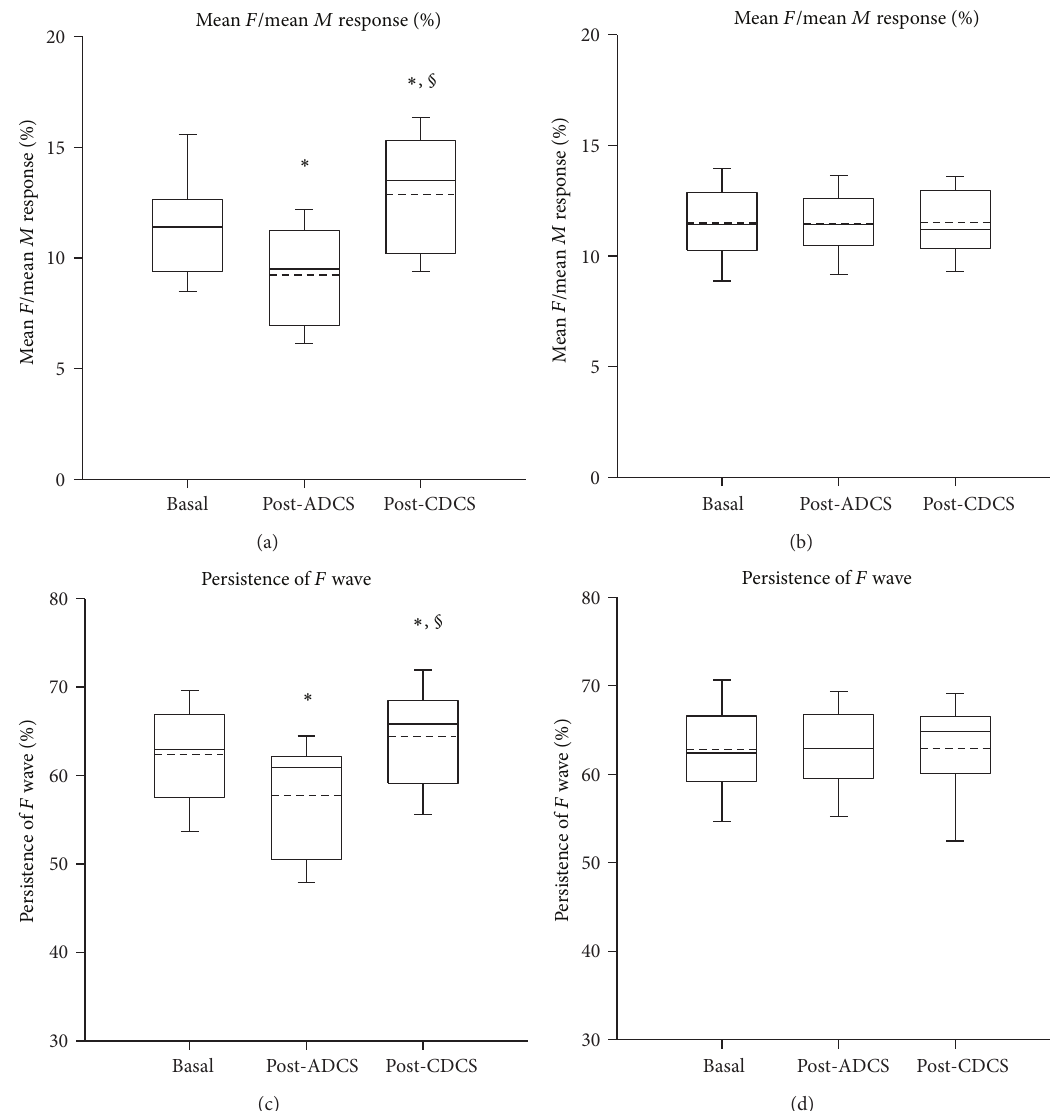
Figure 6: Box and whisker plots showing the changes in the excitability of the anterior horn of the spinal cord, assessed by the ratios mean 𝐹 /mean 𝑀 (expressed in %; (a, b)) and the persistence of the 𝐹 wave (expressed in %; (c, d)) in 𝑛 = 13 rats. Recordings in left gastrocnemius muscle (a, c) and right gastrocnemius muscle (b, d). Basal: values in basal condition; post-ADCS: values obtained after application of anodal direct current stimulation over left cerebellar hemisphere; post-CDCS: values obtained after application of cathodal direct current stimulation over left cerebellar hemisphere. Medians (continuous lines) and means (dashed lines) are illustrated, as well as outliers (corresponding to the 5th and 95th percentiles). In left gastrocnemius muscle, values after ADCS and values after CDCS are significantly lower and higher as compared to the basal values, respectively ( ∗ 𝑃 < 0.05 ). Moreover, values after CDCS are significantly higher as compared to the values after ADCS ( § 𝑃 < 0.05